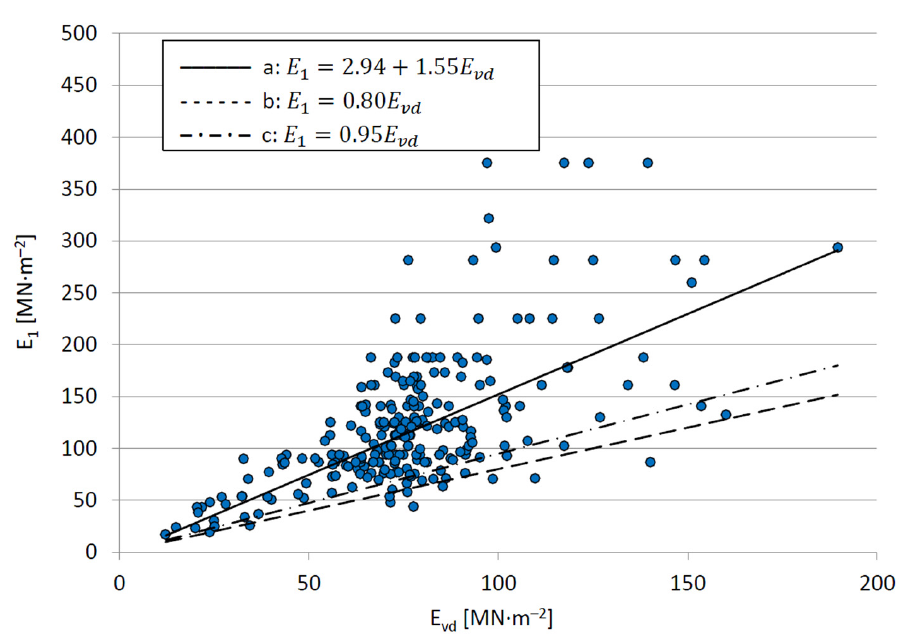
Figure 6. Estimation of the static deformation modulus during primary compression (E 1 ), based on the dynamic deformation modulus (E vd ) values according to the following: ( a ) the proposed linear regression model; ( b ) and ( c ) the simplified conversions from E vd to E 1 , in relation to the bearing capacity measurements that were carried out with a static plate on 245 forest road sections.